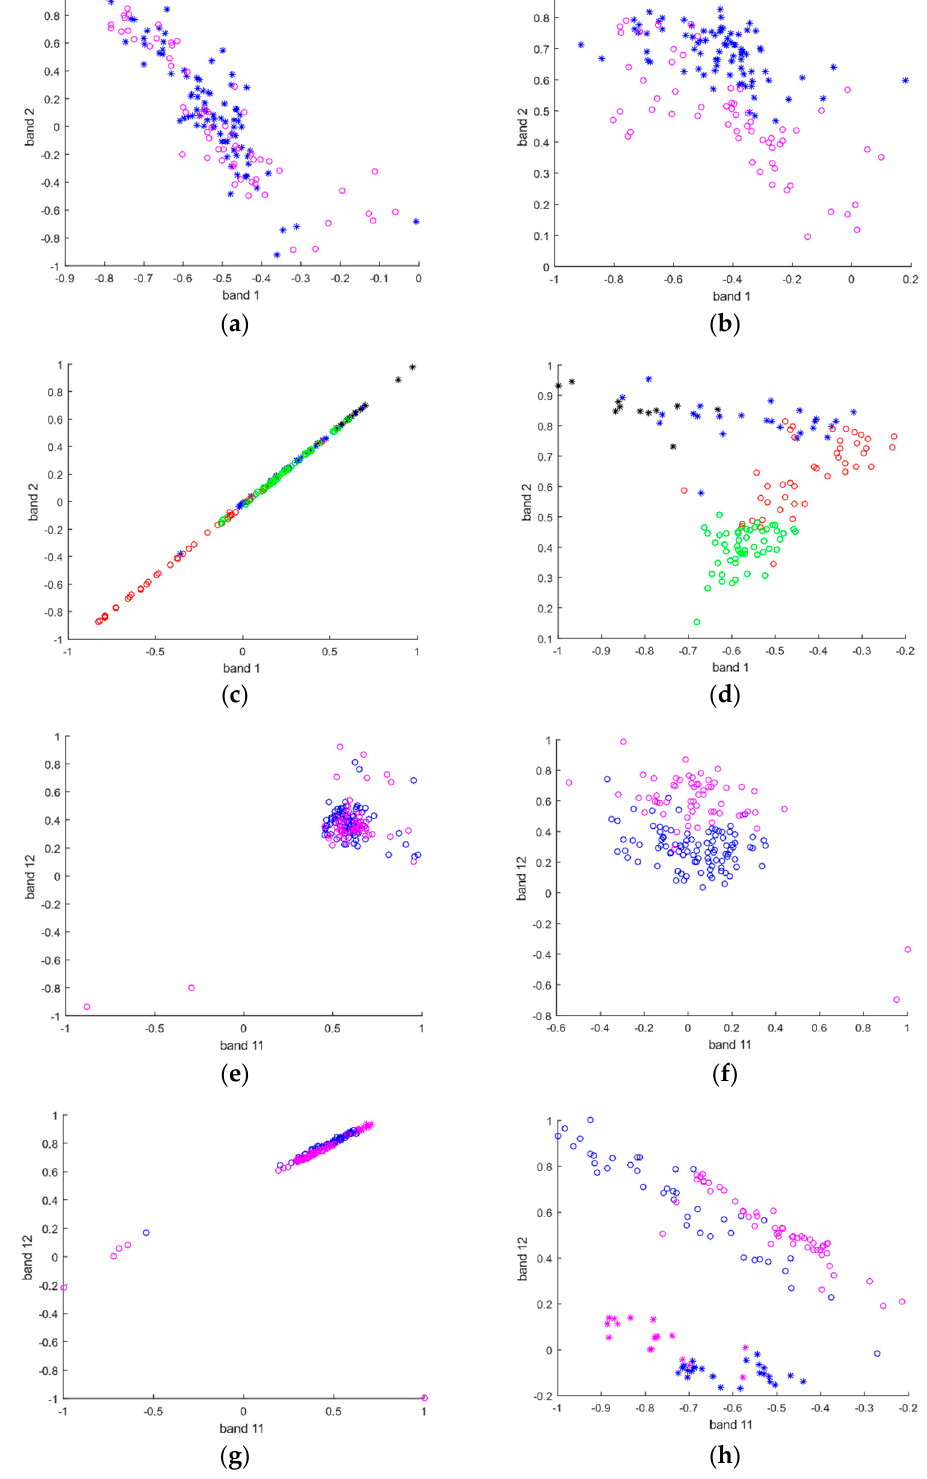
Figure 5. Information of Bands 1 and 2 for “difficult classes”: ( a ) LPP for Indian Pines; ( b ) Proposed + LPP for Indian Pines; ( c ) OLPP for KSC; ( d ) Proposed + OLPP for KSC. Information of Bands 11 and12 for empirically chosen classes: ( e ) LPP for Indian Pines; ( f ) Proposed + LPP for Indian Pines; ( g ) OLPP for KSC; ( h ) Proposed + OLPP for KSC. (LPP: Locality Preserving Projection, OLPP: Orthogonal Locality Preserving Projection).